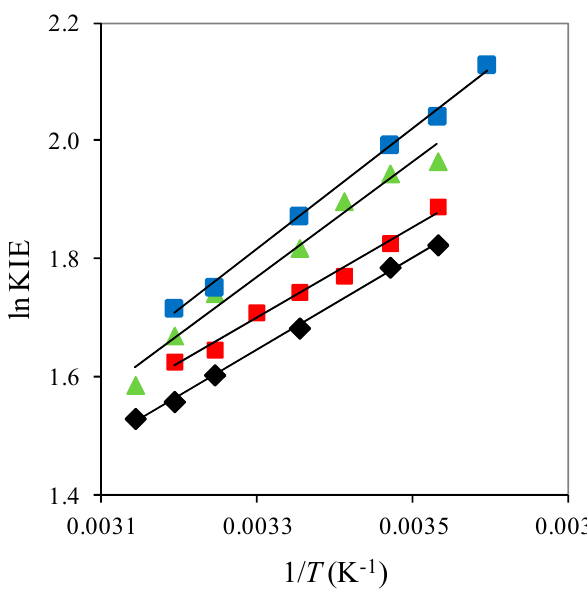
Figure 4. Temperature dependence of KIE in the reaction of ascorbate with hexacyanoferrate(III) ion in different organic cosolvent—water mixtures. Key: black diamond, 1,4-diox:water = 0.05:0.95 v / v ; green triangle, 1,4-diox:water = 0.10:0.90 v / v ; blue square, MeCN:water = 0.10:0.90 v / v ; red circle, EtOH:water = 0.10:0.90 v / v . Abbreviations as noted in Table 1.